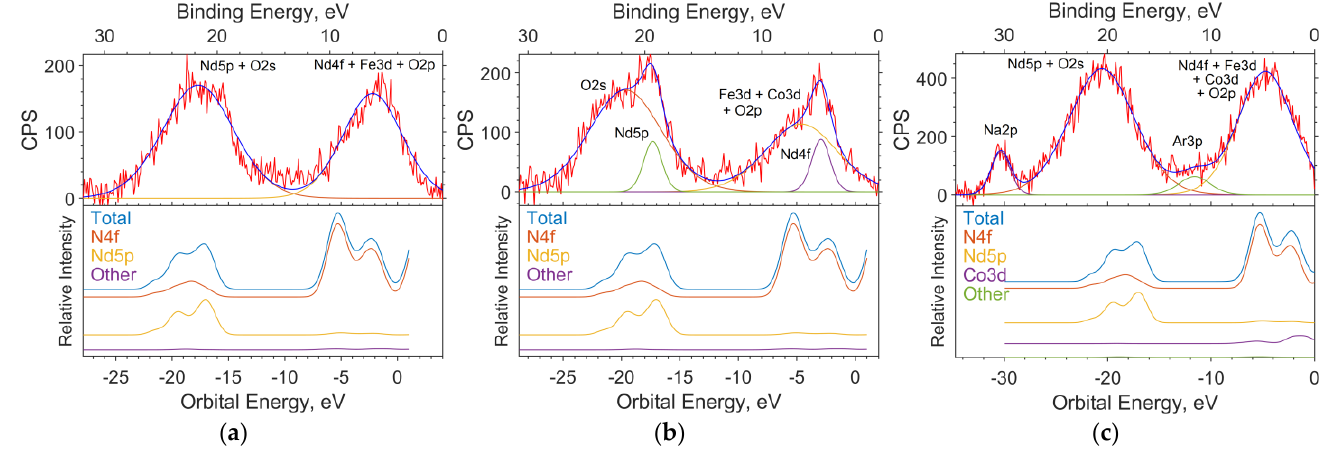
Figure 8. The spectrums of the valence region of the samples with x = 0 ( a ), 0.05 ( b ), and 0.5 ( c ); the theoretical spectrums based on the results of solid-state simulation; and the contribution of individual subshells to the spectrum.